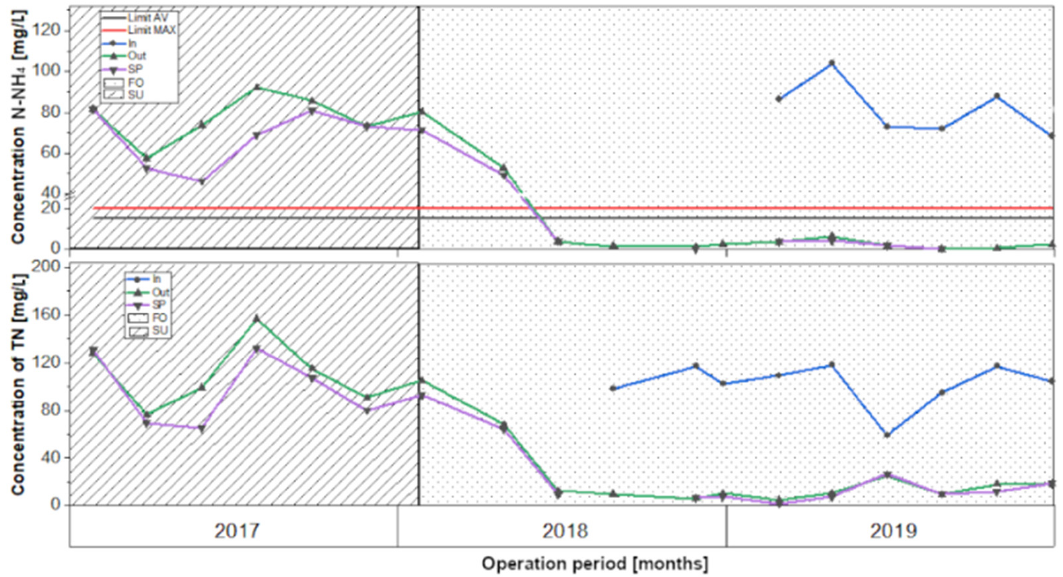
Figure 4. N–NH 4 ( upper ) and TN ( lower ) concentration development. AV = average limit, MAX = maximal limit, In = inlet, Out = outlet, SP = stabilization pond, FO = full operation, SU = start-up phase.